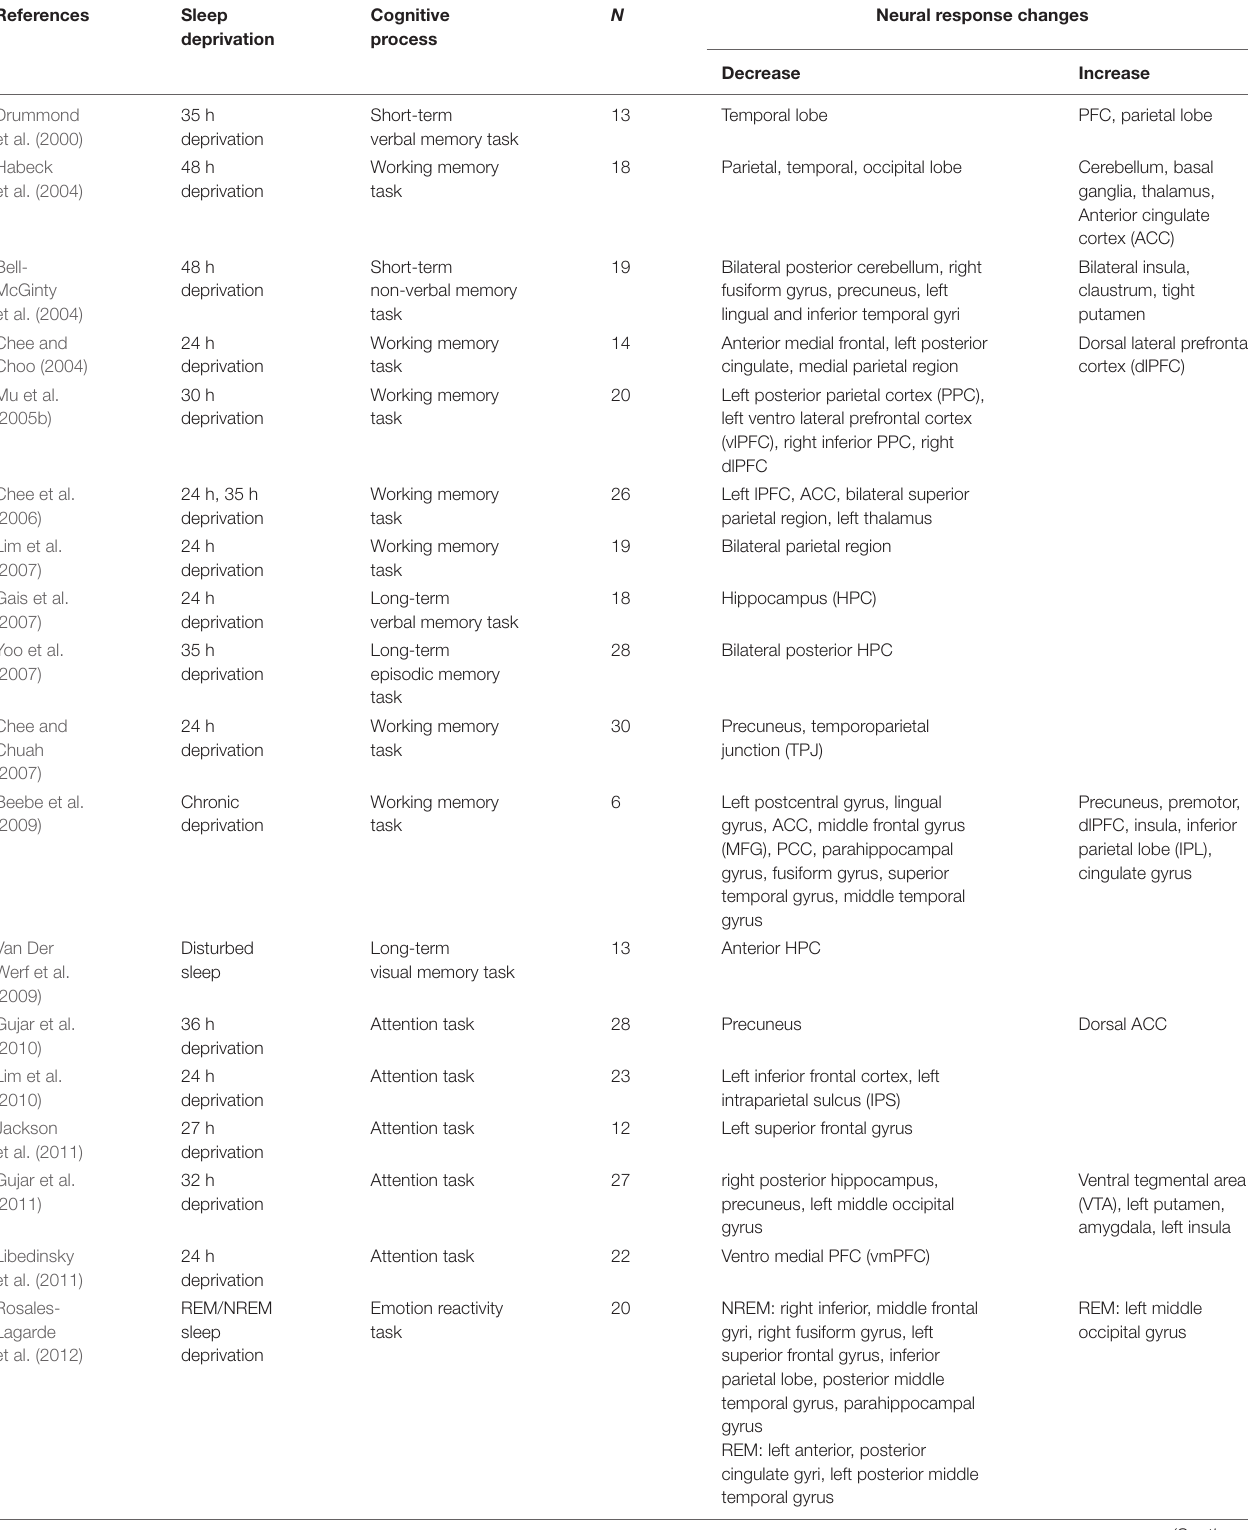
TABLE 4 | Human fMRI studies of the effects of sleep deprivation on neural response changes.